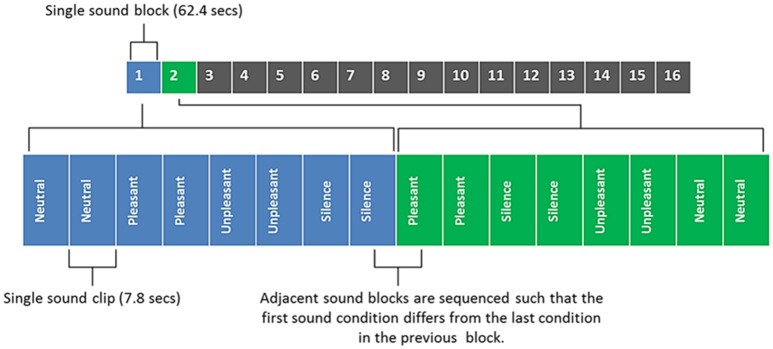
Sound clip sequence, with blocks 1 and 2 being broken down into their component parts for illustrative purposes. Each sound block contains 4 different sound conditions/8 sound clips (each sound clip is repeated in quick succession; with a brief inter-stimulus gap of 450 ms). Total duration of all 16 sounds blocks was 16 min 38 s.